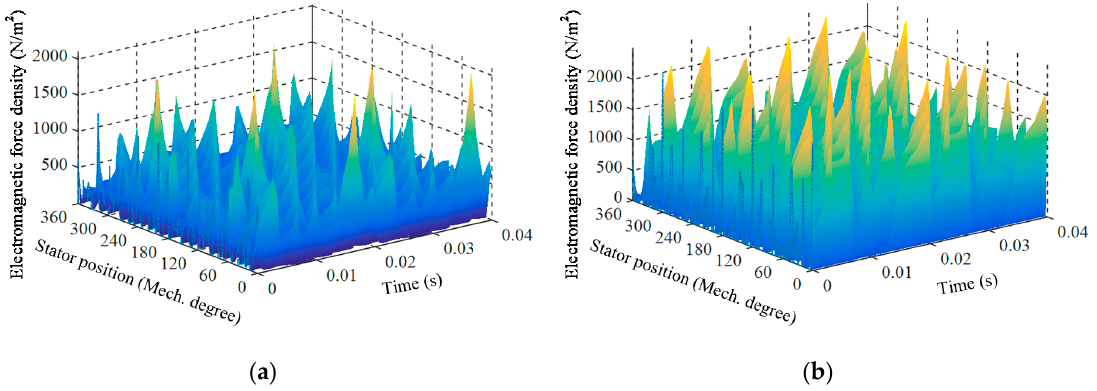
Figure 4. Electromagnetic force density on-load: ( a ) Inner stator; and ( b ) outer stator.